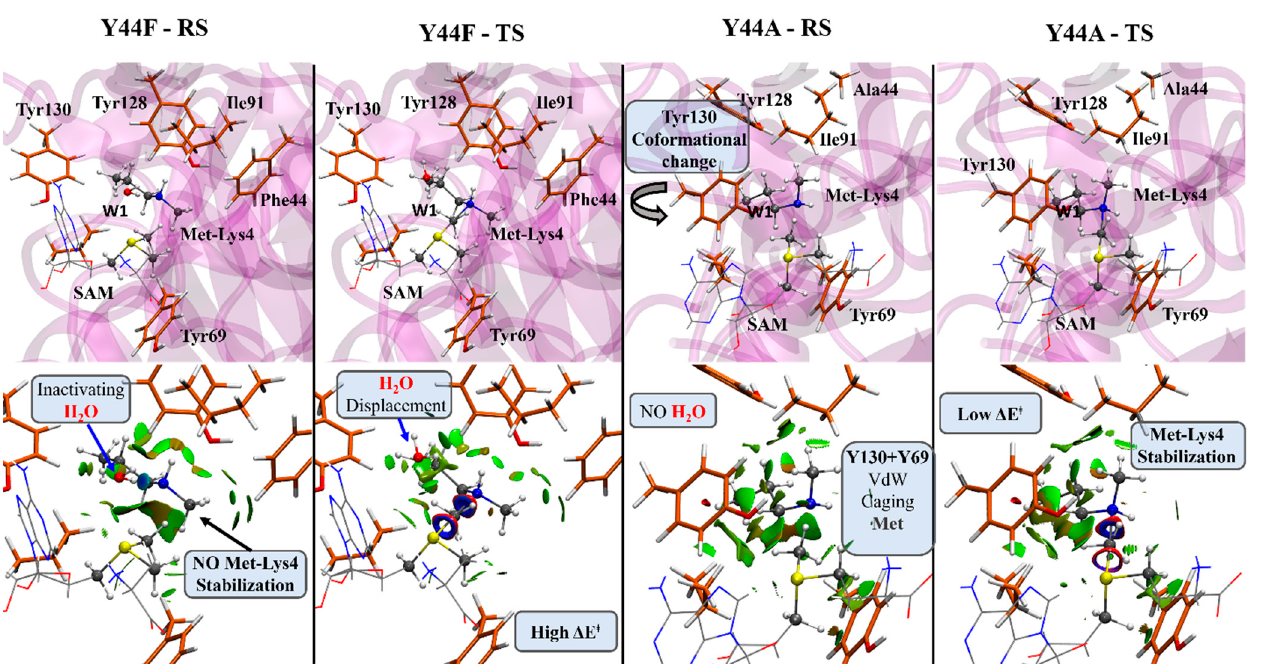
Figure 4. Structural representation of the catalytic site at RS and TS for the di-methyl-transfer reaction performed by Y44F and Y44A mutants. Below, there is a graphic representation in real space of the non-covalent interactions occurring between the methyl group and the enzymatic environment, showing the mechanism for the reactivation of the enzyme through the Y128A mutant ( Δ E ≠ stands for barrier heights; enzyme’s carbon—orange; substrate and cofactor carbon—gray; red—oxygen; blue—nitrogen; white—hydrogen; and the isovalue used as cutoff for the surface is defined as